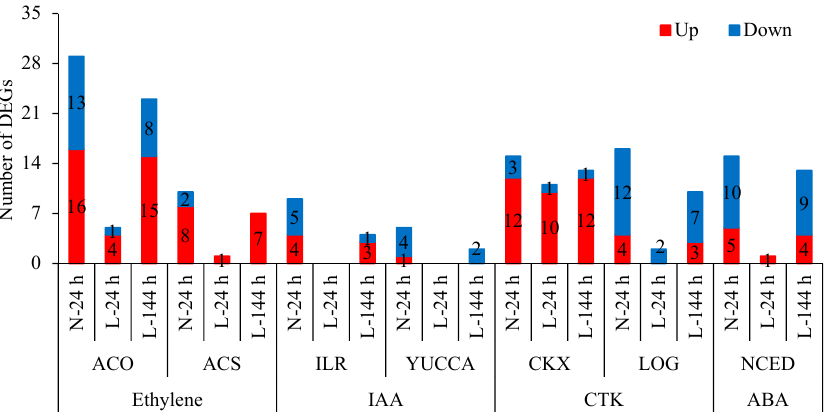
Figure 6. Numbers of plant hormone synthesis and metabolism genes in AZs treated with TDZ at different temperatures. The DEGs are controlled by q -value < 0.05 and |log 2 FC| > 1. Black digits indicate the gene numbers.